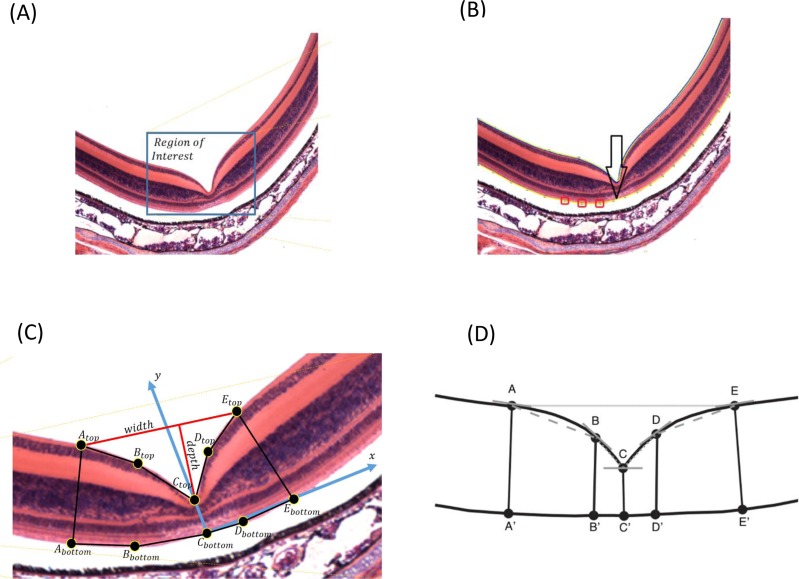
(A) The input to FOVEA is an image of a cross section of retinal tissue. (B) To estimate the foveal pit parameters, there are three key elements: (I) a retina contour (blue) that is automatically detected by the program, (II) control points (red) that are defined by the user, and (III) a reference curve (yellow) that is established by the program. FOVEA establishes different points considering the retina contour and the reference curve (Atop, Abottom, Btop, Bbottom, Ctop, Cbottom, Dtop, Dbottom, Etop, and Ebottom) to estimate fovea width and depth (C), and measures the slopes between points A–B, B–C, C–D, D–E (D) as proxies of the inclination of the foveal walls.